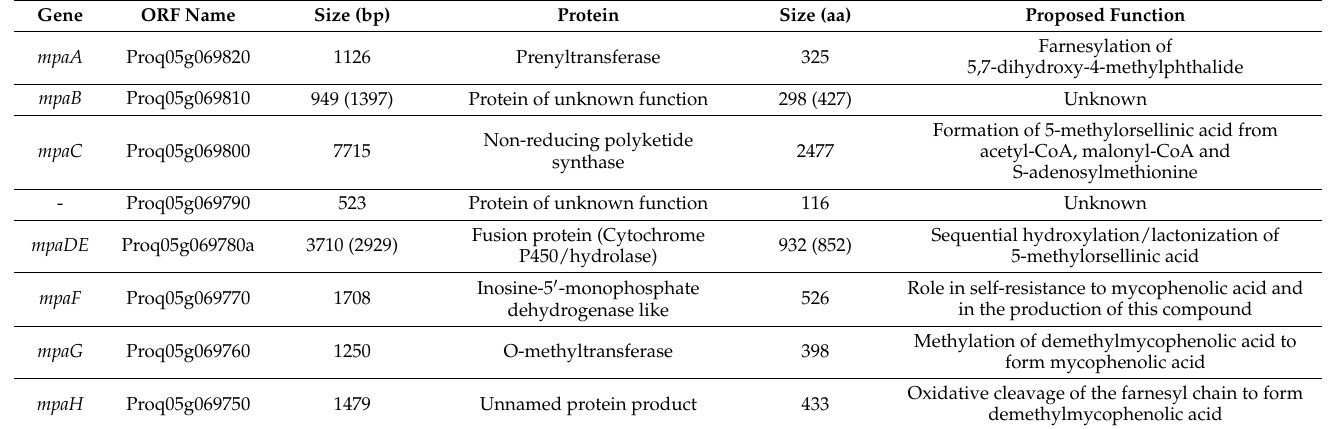
Table 4. Mycophenolic acid biosynthetic gene cluster in P. roqueforti